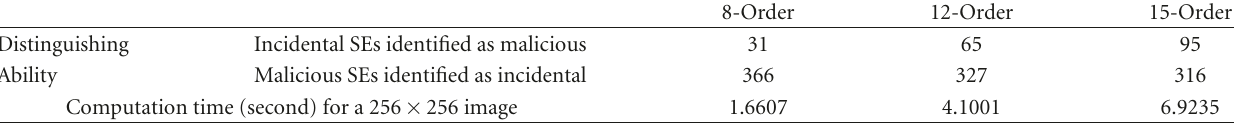
Table 1: Comparison of 8-order, 12-order, and 15-order Zernike